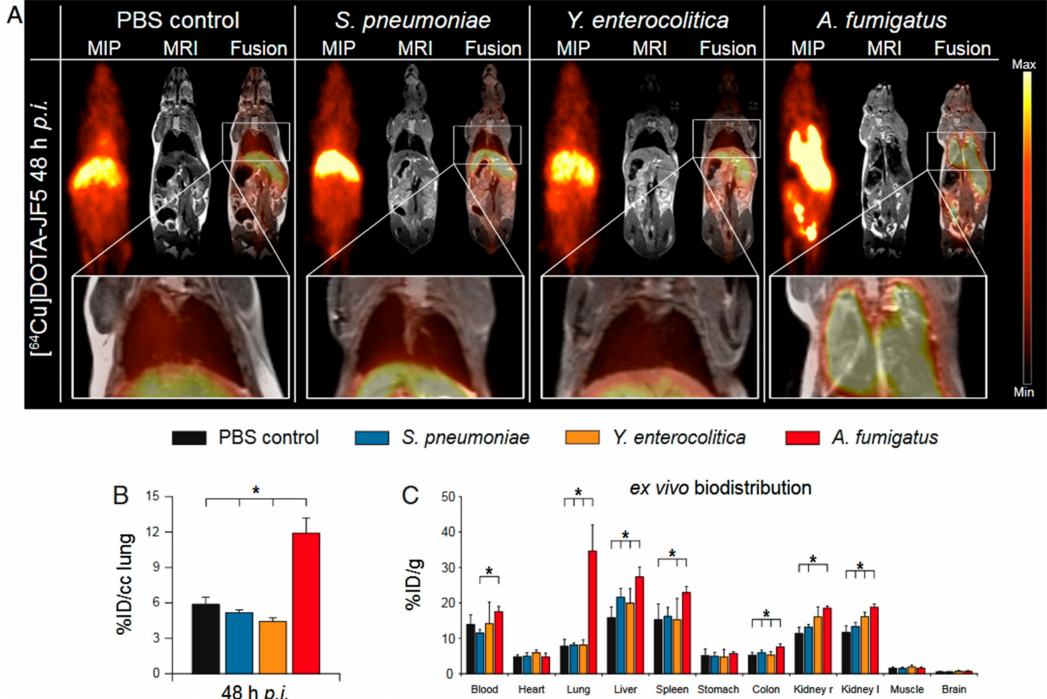
Figure 5. Preclinical JF5-based PET imaging of aspergillosis in mice. ( A ) [ 64 Cu]Cu-DOTA-mJF5 PET coronal maximum intensity projection (MIP) and magnetic resonance images (MRI) overlayed (Fusion) in control (PBS inoculated), S. pneumoniae , Y. enterocolitica and A. fumigatus lung infections. Close-up of the lung area in the insert below. ( B ) Quantification of in vivo radiotracer accumulation in the lungs 48 h post injection ( p.i. ). ( C ) Quantification of radiotracer bio-distribution ex vivo in excised organs. Data are expressed as the average ± standard deviation of the injected dose (ID), one-way ANOVA, * p < 0.05. Adapted from Rolle et al. Proc. Natl. Acad. Sci. USA 2016, 113 ,